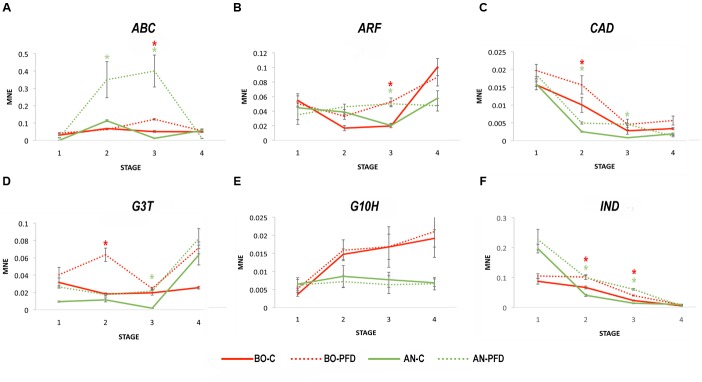
Real-time qPCR analysis of PFD treatment molecular markers of Sangiovese cultivar in 2013. Real-time qPCR analysis of the (A) ABC transporter VvPDR20-VvABCG50 (ABC; VIT_06s0061g01490), (B) Auxin response factor 10 (ARF; VIT_13s0019g04380), (C) Cinnamoyl alcohol dehydrogenase (CAD; VIT_00s0615g00020), (D) Flavonoid 3-O-glucosyltransferase (G3T; VIT_11s0052g01630), (E) Geraniol 10-hydroxylase (G10H; VIT_15s0048g01490) and (F) Indole-3-acetate beta-glucosyltransferase (IND; VIT_13s0019g03040) expression profiles in PDF and C Sangiovese vines during berry development in 2013. The mean normalized expression (MNE)-value was calculated for each sample referred to the VvUBIQUITIN1 (VIT_16s0098g01190) expression according to the Simon equation (Simon, 2003). Bars represent means ± SE of three biological replicates. The significant modulation (t-test, p < 0.05) of gene expression between C and PFD berries at each stage per each site is indicated by an asterisk, red for BO and green for AN.